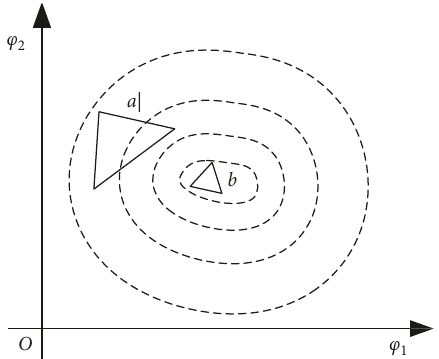
Figure 4: Contour-plotted function with the simplex a and the simplex b in a two-dimensional